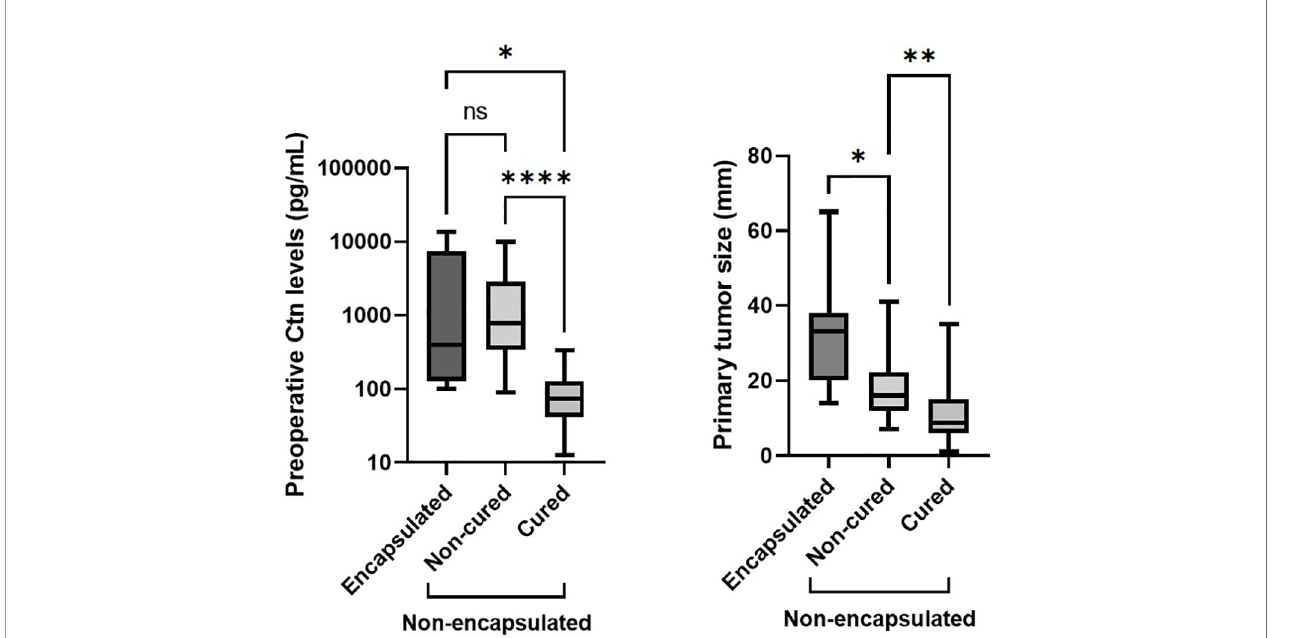
FIGURE 2 | Comparing E-MTCs with non-cured NE-MTCs ( Table 2 ), there were no signi fi cant differences in term of preoperative Ctn levels (p = 0.633, left side) but there were for primary tumor size (p = 0.036, right side), which was higher in the former (median 33 mm versus median 16 mm, respectively). Among NE-MTCs, higher preoperative serum Ctn (p < 0.0001) and greater tumor size (p = 0.008) were seen in non-cured patients than those cured. Ctn, calcitonin; ns, not signi fi cant. The asterisks refer to the different p values indicated in the caption of the fi gure (*p = 0.036, **p = 0.008, ****p <